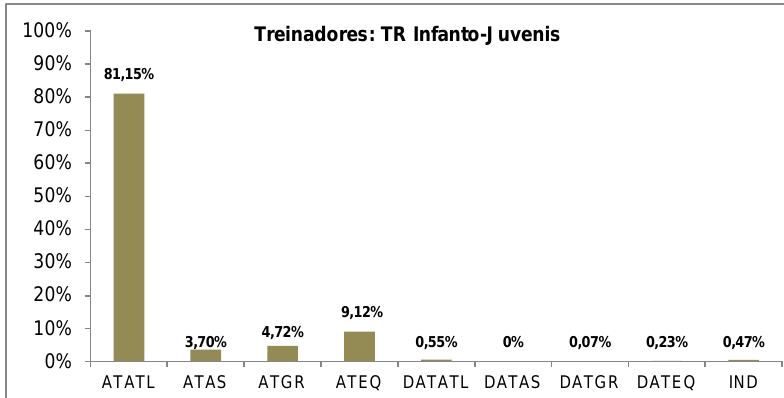
Figura 3. Valores em porcentagem da dimensão Atenção durante a competição (ATATL – Atenção Atleta; ATAS – Atenção Atleta Suplente; ATGR – Atenção Grupo; ATEQ – Atenção Equipa; DATATL – Desatenção Atleta; DATAS – Desatenção Atleta Suplente; DATGR – Desatenção Grupo; DATEQ – Desatenção Equipa; IND – Indeterminado).